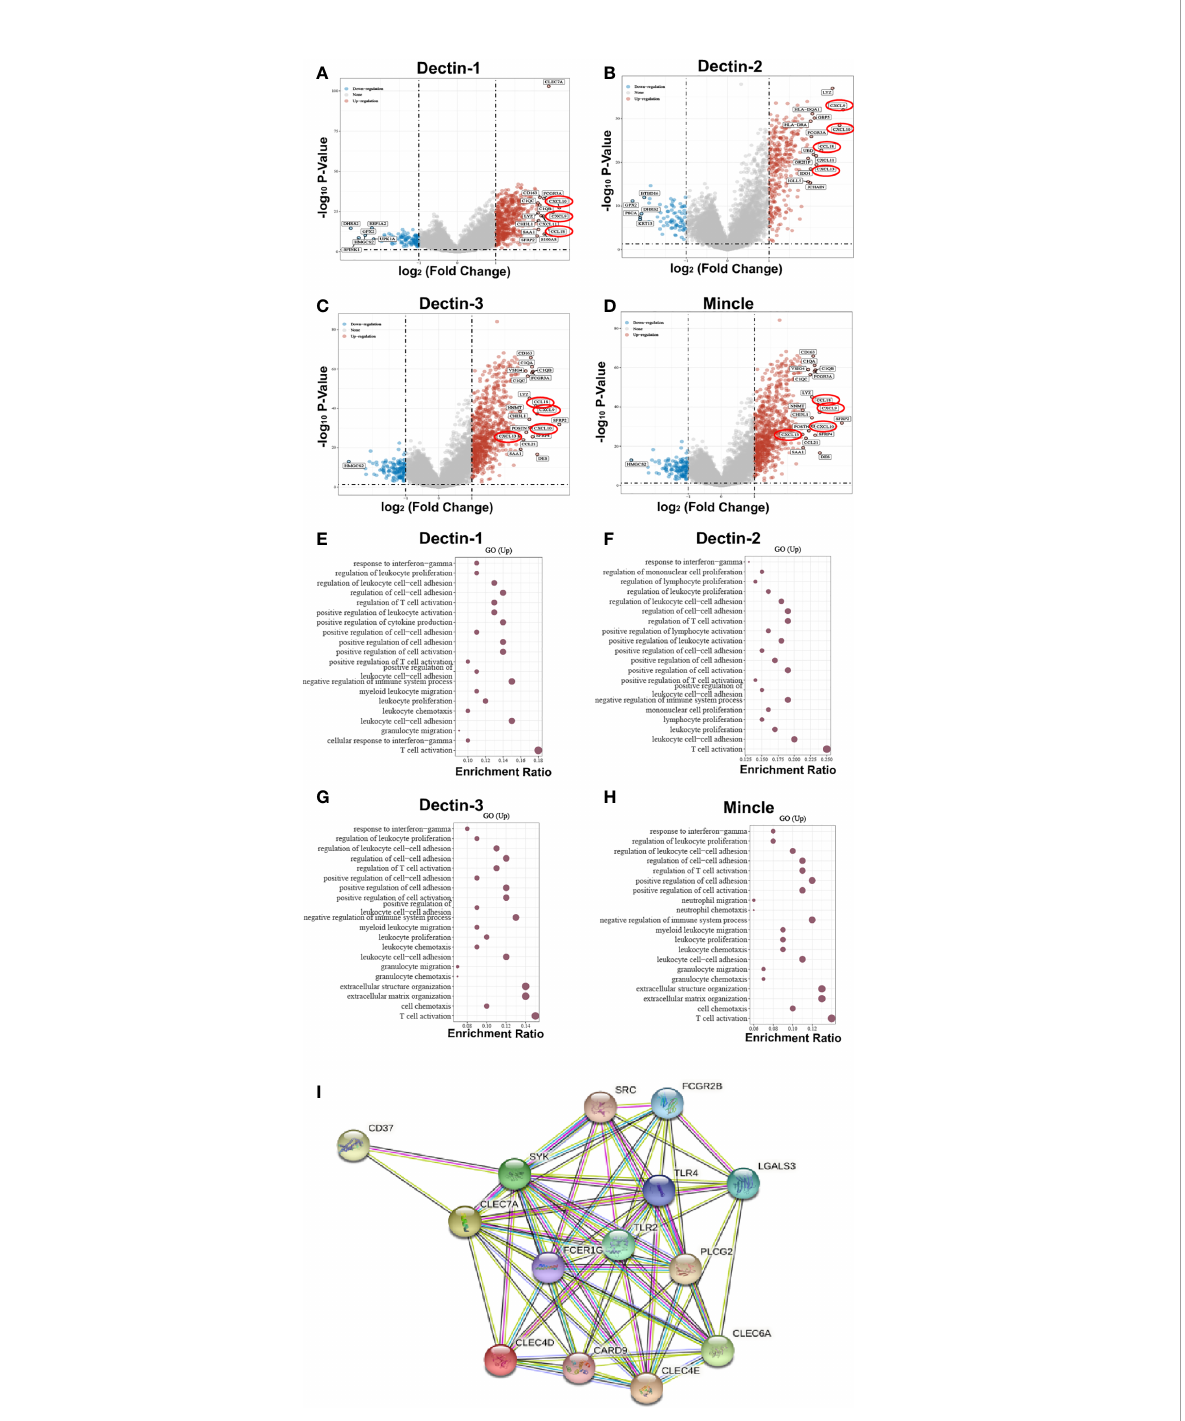
FIGURE 3 DEGs were found in bladder cancer patients in the CLR-high and CLR-low groups (A – D) . The CXC subfamily chemokines of CXCL9, CXCL10, and CXCL13, and the CC subfamily chemokine of CCL18 were found to be consistently expressed in bladder cancer patients in the CLR-high group, and levels of expression were signi fi cantly higher among bladder cancer patients in the CLR-high group than among the those in the CLR-low group. CLR gene enrichment pathway prediction based on the DEGs in bladder cancer patients (E – H) . Protein crosstalk networks centered on CLRs using STRING (I) . Toll-like receptor 2 (TLR2), toll-like receptor 4 (TLR4), and Fc epsilon receptor Ig (FCER1G) are the predicted functioning partners with